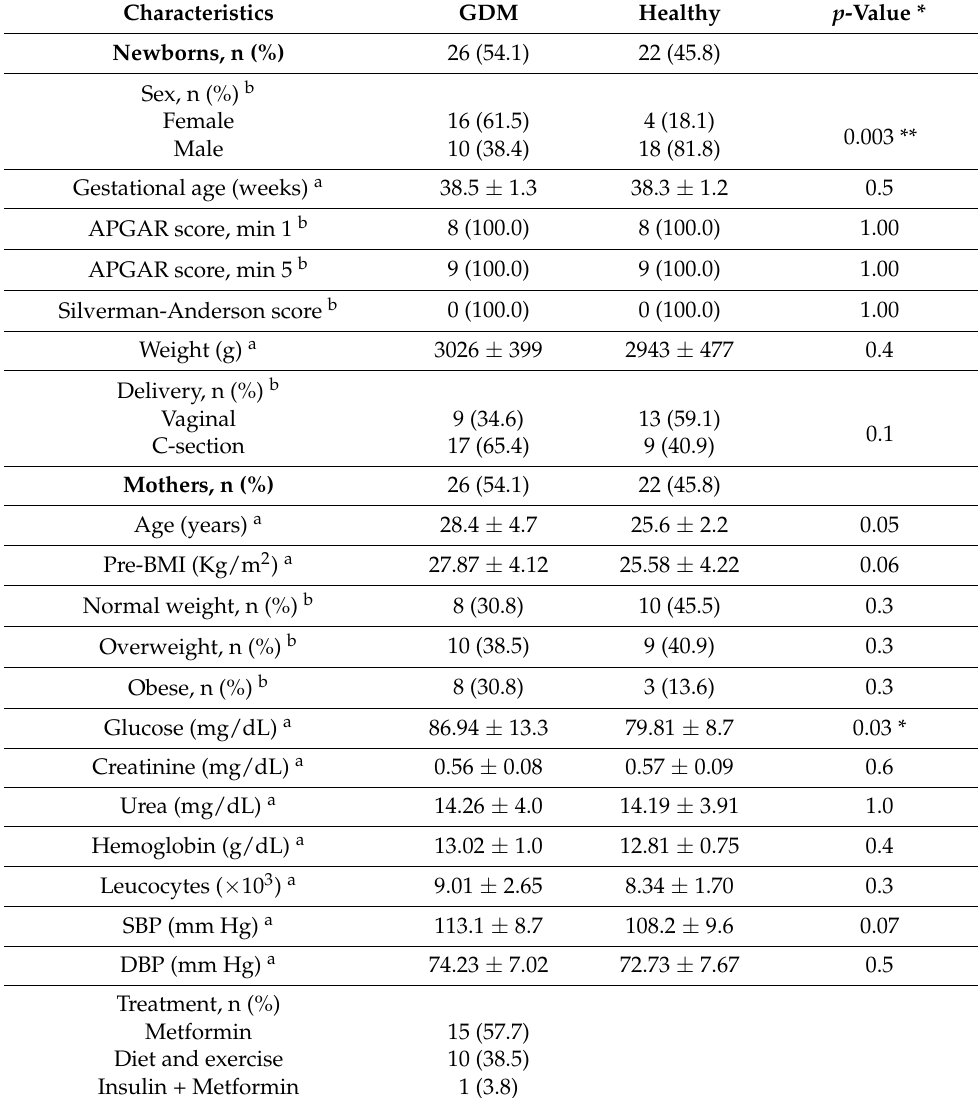
Table 1. Comparison of selected characteristics of the pregnant women and their newborns by diabetes status of the